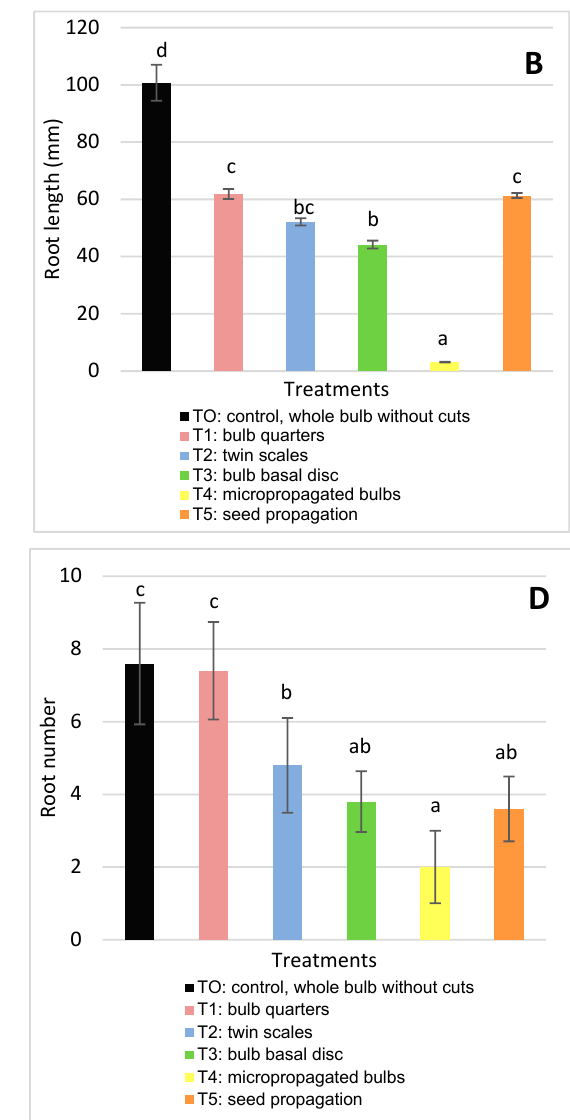
Figure 4. Effect of the propagation method on biomass increase ( A ); root diameter ( B ); root length ( C ); and root number ( D ). Means and standard deviation are reported. Data were analyzed by ANOVA and different letters (a, b, c, d) indicate significant differences by the Tukey test (p < 0.05). The treatments were: T0 (Control): whole bulb, T1: bulb quarters, T2: twin scales, T3: bulb basal discs, T4 micro propagated bulbs and T5: seed propagated bulbs.